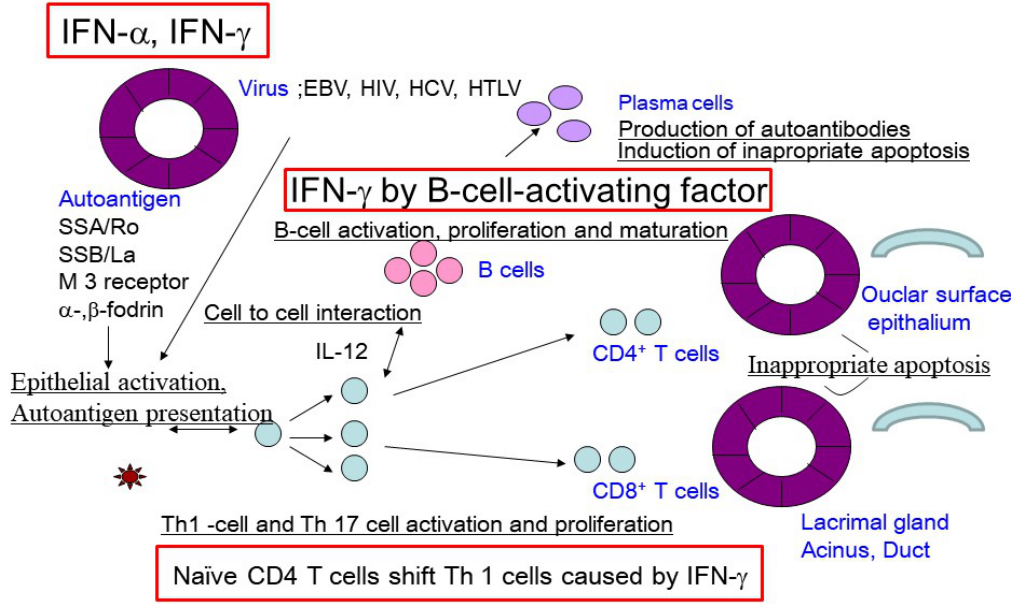
Figure 2. Hypothetical pathogenic process of Sjögren’s syndrome related dry eye diseasemodified form Sumida, T. et al [67].Viral infection acts as a trigger for the autoimmune response in SS. SS-associated ribonucleoprotein autoantigens, including Ro60/SSA, La/SSB, α -fodrin, β -fodrin, and M3 muscarinic acetylcholine receptor, are released by epithelial activation and damage. Epithelial cells are activated by IFN signaling pathways, followed by the subsequent infiltration of lymphocytes, primarily T cells, into the lacrimal glands and the secretion of B-cell-activating factor by epithelial cells. The subsequent B-cell activation and maturation as plasma cells results in the secretion of altered autoantibodies. These processes stimulate a chronic immune cascade, leading to lacrimal gland and ocular surface dysfunction and thus to dry eye. EBV; Epstein-Barr Virus, HIV; Human Immunodeficiency Virus, HCV; Hepatitis C Virus, HTLV; Human T-lymphotrophic Virus.